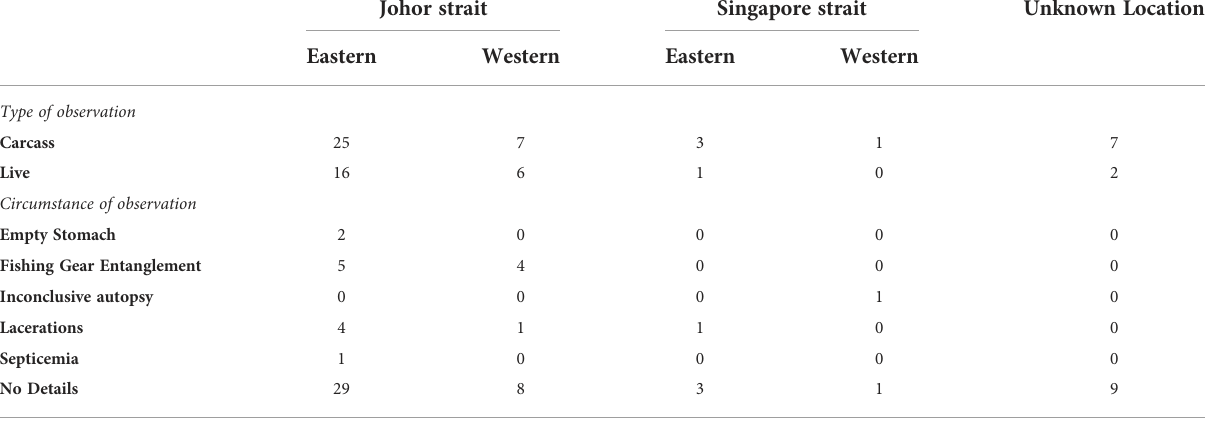
TABLE 2 Dugong observations along the coastlines of southern Johor and Singapore between 1820 and 2021. Refer to Table S1 for more details. Johor